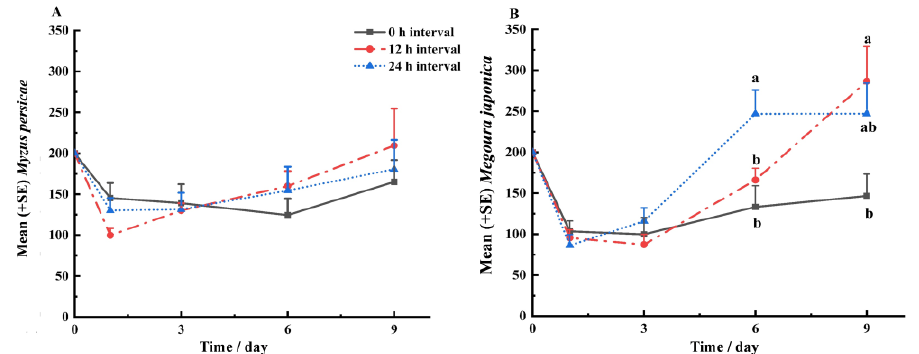
Figure 2. Myzus persicae ( A ) and Megoura japonica ( B ) numbers at different times after the release of Coccinella septempunctata with different release intervals. Different lowercase letters within the same sampling date indicate significant differences ( p < 0.05).